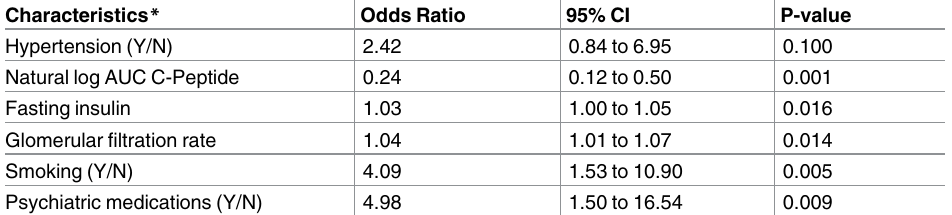
Table 3. Stepwise ordered logistic regression analysis * with oxytocin tertiles as the dependent variable. Characteristics